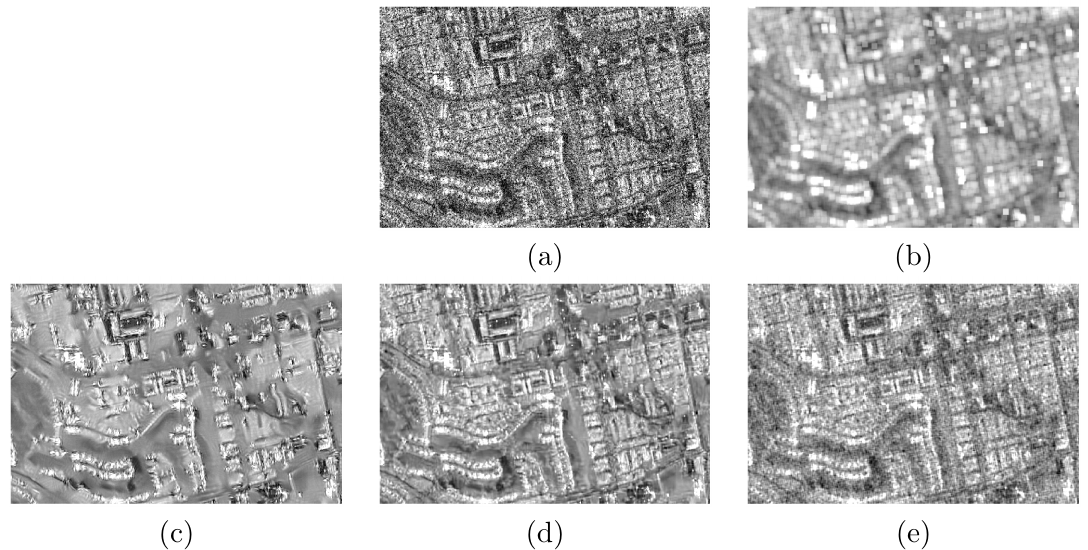
Figure 12. Houston test case. Zoom of a selected area obtained for: ( a ) noisy SAR data, ( b ) Kuan, ( c ) PPB-it, ( d ) FANS, and ( e ) EWF.